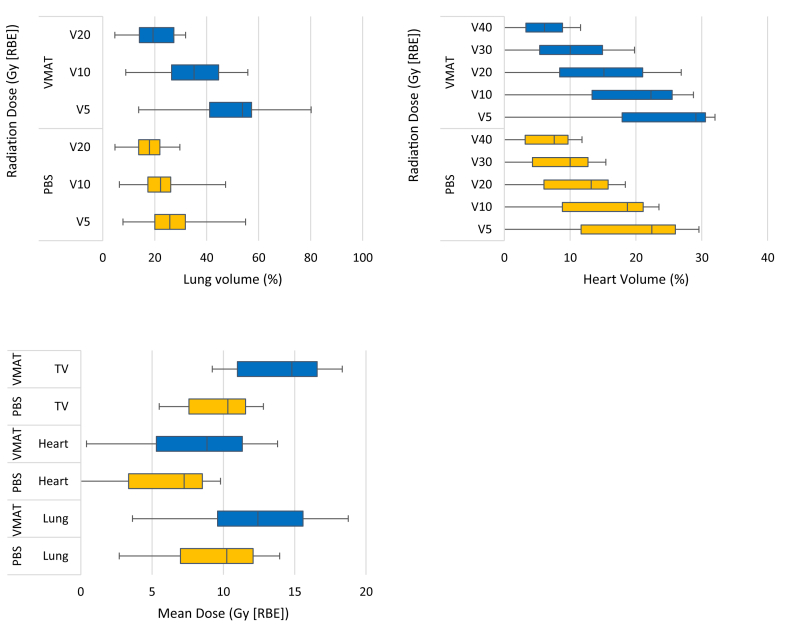
Box plot of distributions of dose–volume indices for the lungs, heart and thoracic vertebrae (TV) when planned with pencil beam scanning protons compared with volumetric-modulated arc therapy for 10 patients with superior sulcus tumours. Whiskers show range and boxes show quartiles 1, 2 and 3. Pencil beam scanning protons reduced the mean lung dose by 21.9% (mean 9.4 Gy(RBE), P < 0.01), lung V20 by 12.1% (mean 17.4%, P < 0.05), lung V10 by 36.4% (mean 21.8%, P < 0.01), lung V5 by 47.9% (mean 25.5%, P < 0.01), mean heart dose by 21.4% (mean 6.4 Gy(RBE), P < 0.05) and mean thoracic vertebra dose by 29.2% (mean 10.0 Gy (RBE), P < 0.01).